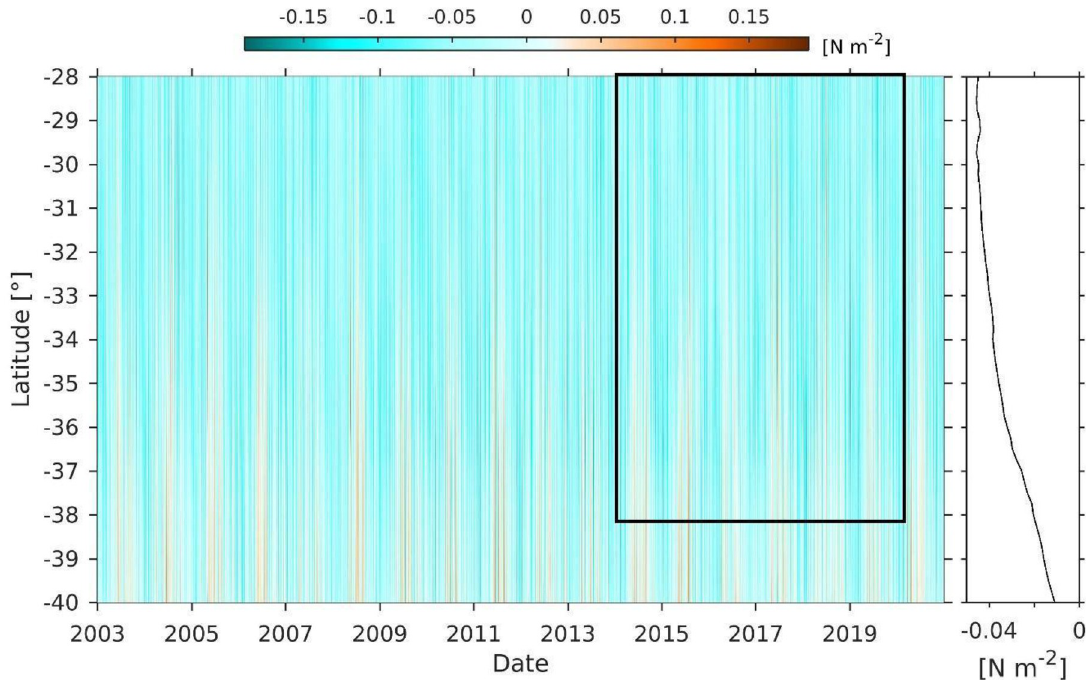
Fig 10. Hovmo¨ller diagram of daily-averaged coastal (100 nm) northerly (red)-southerly (blue, upwelling-favourable) wind-stress (N m -2 ) between 28˚S and 40˚S. The black box indicates the spatio-temporal scale of the discard data of the crustacean demersal fishery. The right panel shows latitudinal variation in the mean value throughout the series.